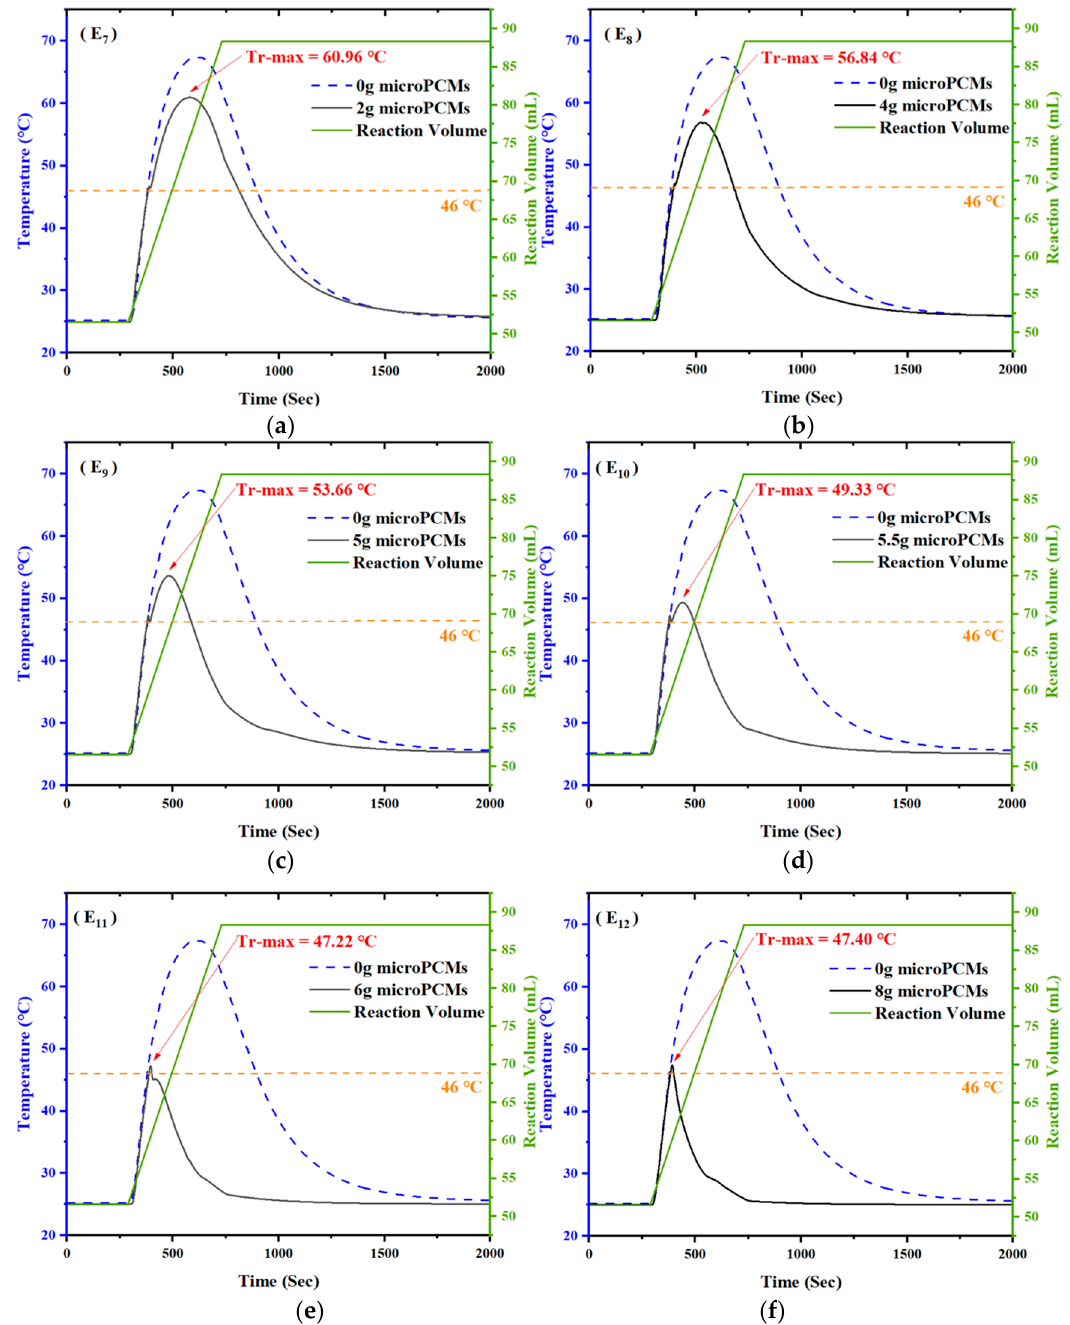
Figure 12. Experimental results with addition amount of ( a ) 2 g, ( b ) 4 g, ( c ) 5 g, ( d ) 5.5 g, ( e ) 6 g, ( f ) 8 g microPCMs at the temperature of 39 °C.